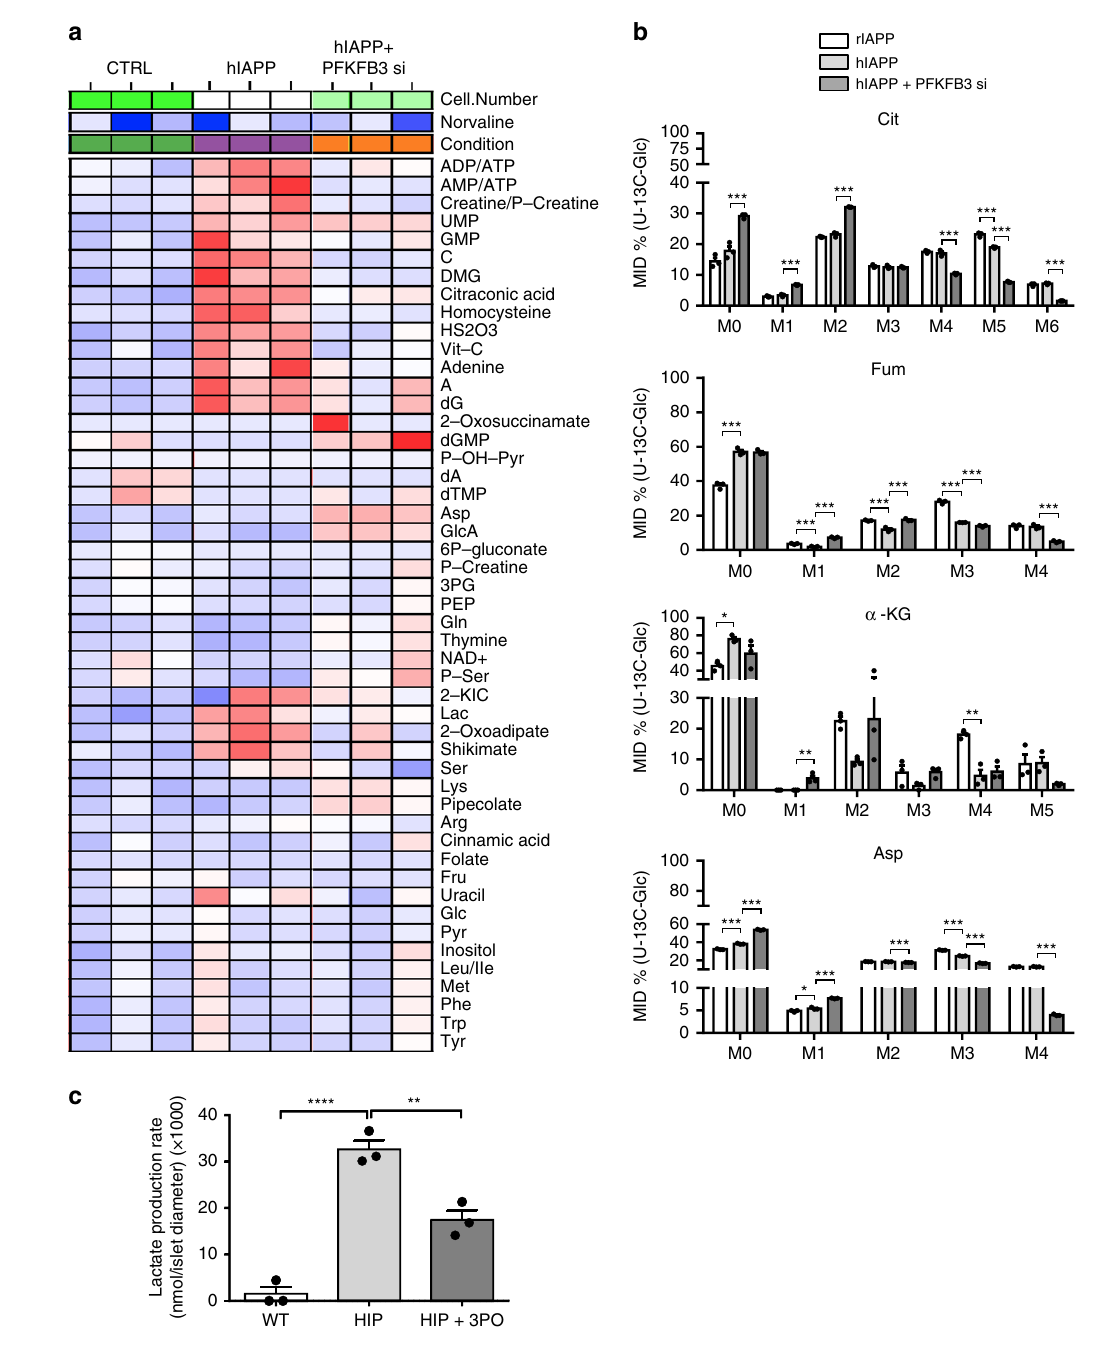
Fig. 6 Silencing of PFKFB3 restores the β -cell metabolome. a Heatmap of relative metabolite composition in LacZ (CTRL) and hIAPP overexpressing INS 832/13 cells in the presence or absence of PFKFB3 siRNA. b Mass isotopomer distribution (MID) of the TCA metabolic intermediates from cultured INS 832/13 cells with [U- 13 C 6 ] labeled glucose. Citrate — Cit; Fumarate — Fum; α -ketoglutarate — α -KG; Aspartate — Asp. c Lactate production rate of islets from WT and HIP rats treated or not with 3PO for 24 h. Data are presented as mean ± SEM, n = 3 independent biological samples for each group. Statistical signi fi cance was analyzed by one-way ANOVA test with Tukey ’ s post-test (* p < 0.05, ** p < 0.01, *** p <